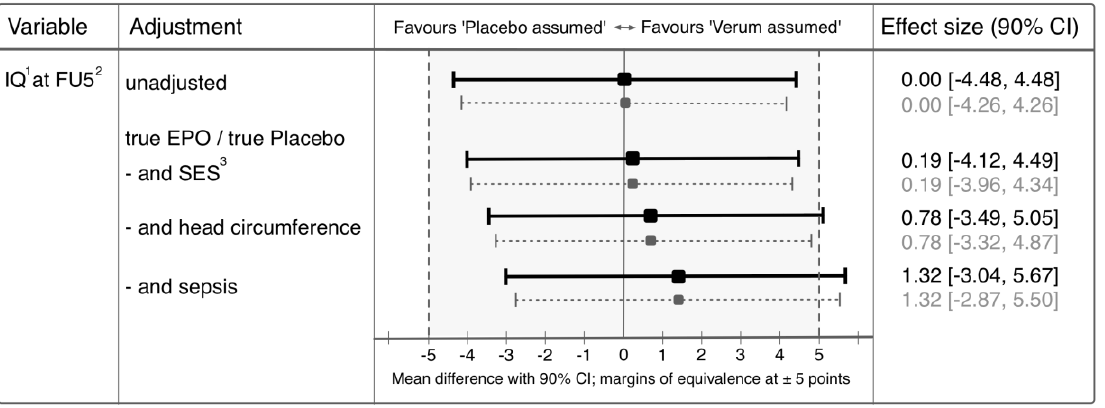
Figure 2. Confidence intervals (CIs) for the difference in mean IQ at FU5 between the PAV and PAP groups: unadjusted and gradually adjusted for the effect of verum/placebo and SES, head circumference, and sepsis. CIs in solid black lines are based on a linear regression using data of infants whose parents answered the questionnaire and had complete information on verum/placebo, SES, head circumference, and sepsis ( n = 105); CIs in grey dotted lines are based on a bias-corrected missing indicator method, using data of all infants with complete information on verum/placebo, SES, head circumference, and sepsis (infants of parents with ( n = 105) and without ( n = 83) completed questionnaire). 1 IQ: intelligence quotient, 2 FU5: 5-year follow-up examination, 3 SES: socioeconomic